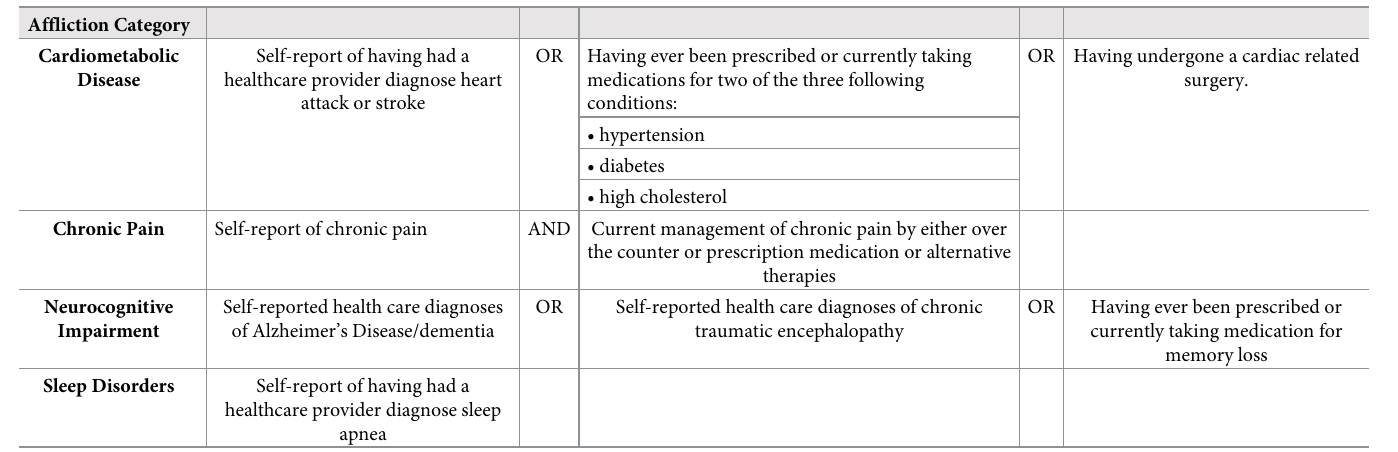
Table 1. Definitions used for health afflictions in the In-Person Assessment